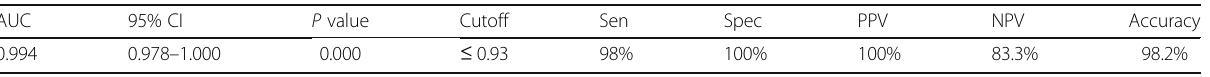
Table 3 To explore the discriminant ability of mean ADC value to differentiate (grade II and III) from (grades I) tumors AUC 95% CI P value